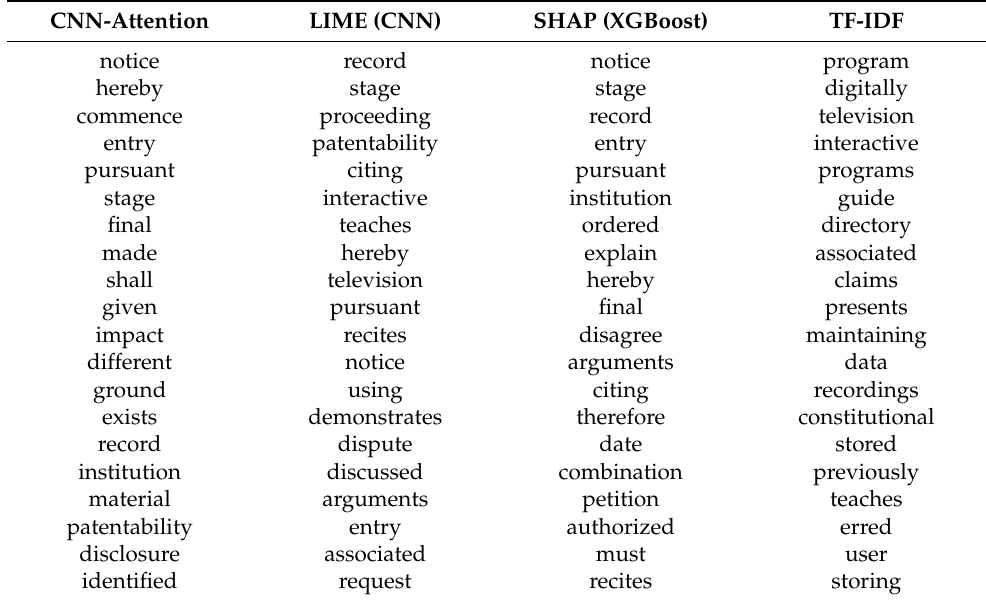
Table 1. Top 20 words by mean attention (obtained from trained CNN classifier), LIME (for the CNN classifier), SHAP value (after XGBoost classification), and TF-IDF score (i.e., no classification) for the written decision in